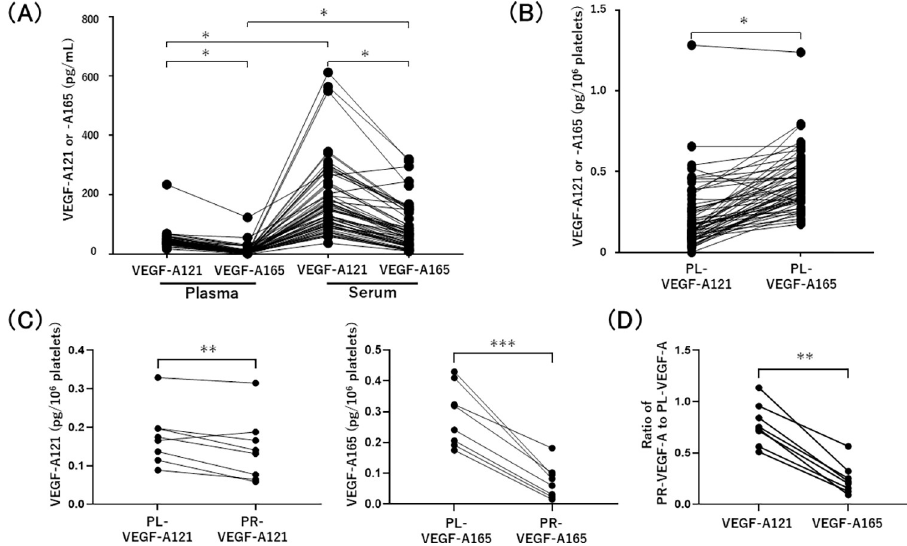
Fig 6. VEGF-A165 is more abundant than VEGF-A121 in human platelets. (A, B) VEGF-A121 and VEGF-A165 in plasma and serum (A) and those in platelet lysate (PL-VEGF-A121 and PL-VEGF-A165) (B) were measured by isoform specific ELISAs (n = 59). (C) VEGF-A121 released from aggregating platelets (PR-VEGF-A121) and VEGF-A121 in platelet lysate (PL-VEGF-A121) were the same levels for 10 6 number of platelets (left panel). VEGF-A165 released from aggregating platelets (PR-VEGF-A165) was significantly lower than VEGF-A165 in platelet lysate (PL-VEGF-A165) (right panel) (n = 8). (D) The ratio of PR-VEGF-A121 to PL-VEGF-A121 and that of PR-VEGF-A165 to PL-VEGF-A165 in the same number of platelets were calculated from (C). * P < 0.0001, ** P < 0.05, and *** P < 0.001.